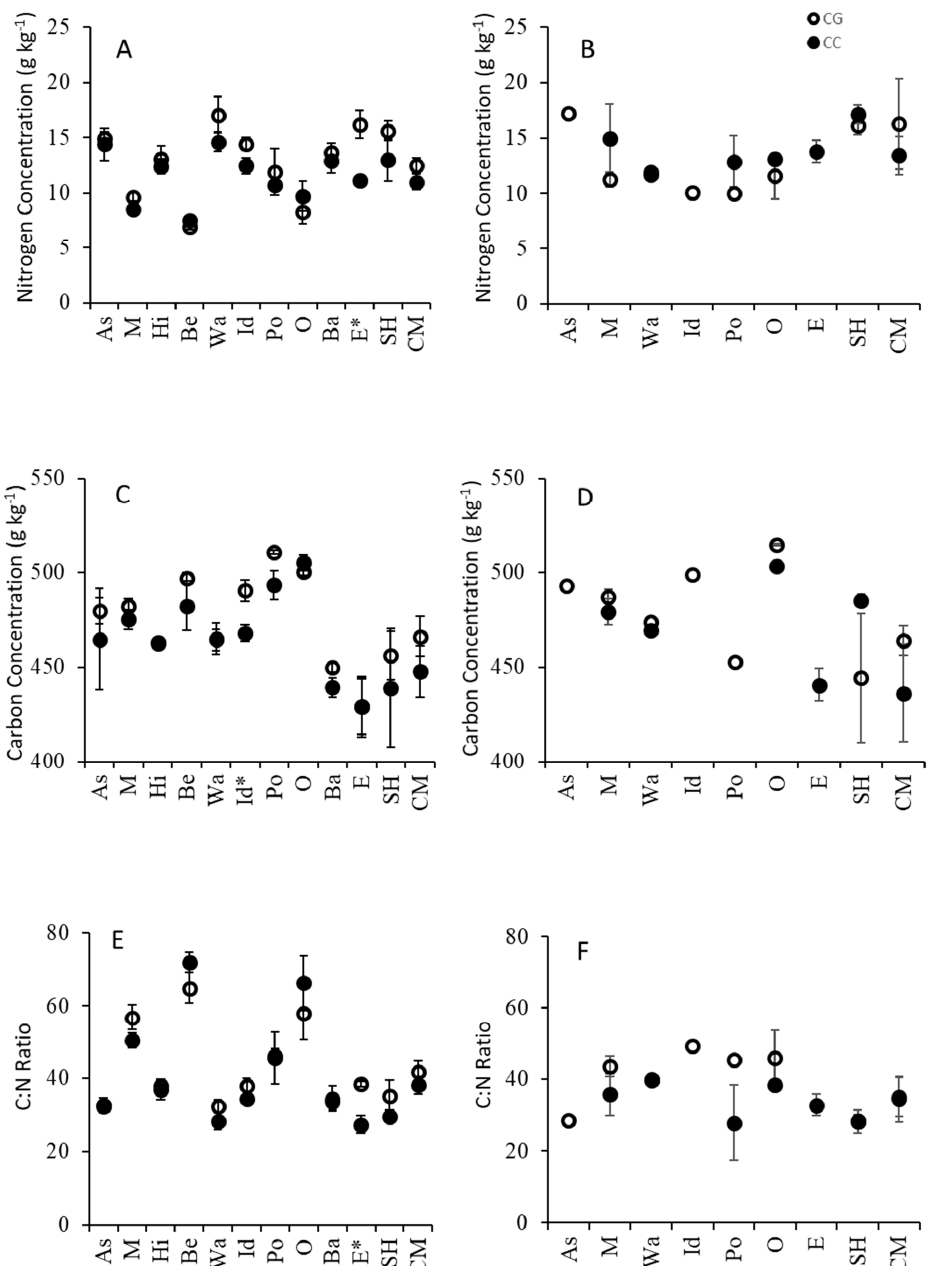
Figure 4. Mean (± standard deviation) leaf litter nitrogen (A,B) and carbon (C,D) concentrations (g kg − 1 ) and C:N ratio (E,F) in the new (left ‐ hand plots) and old (right ‐ hand plots) infestations. Asterisk indicates tree genera with significant difference in nitrogen concentration ( p < 0.05) between Canopy Gap (CG) plots and Canopy Closed (CC) plots (Student’s t ‐ test: (A) elm p = 0.009, (C) ironwood p = 0.015, (E), elm ( p = 0.004). As (Ash— Fraxinus ), M (Maple— Acer ), Hi (Hickory— Carya ), Be (Beech— Fagus ), Wa (Walnut— Juglans ), Id (ironwood— Ostrya ), Po (Polar— Populus ), O (Oak— Quercus ), Ba (Basswood— Tilia ), E (Elm— Ulmus ), SH (shrub), CM (Coarse Material).